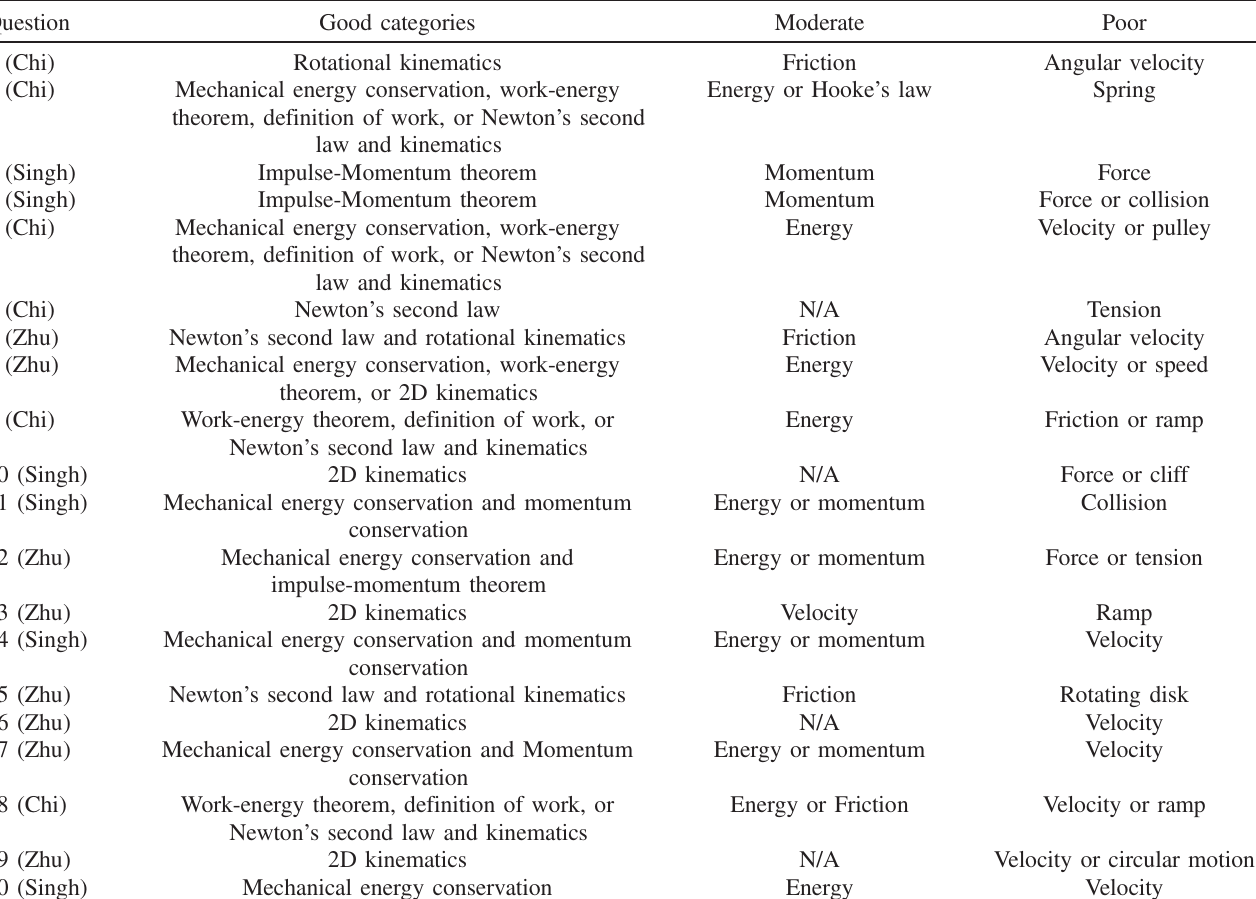
TABLE I. Examples of good, moderate, and poor categories for each question. The family name in parentheses represents the source of the question. The item N/A represents that few of the students ’ answers were evaluated as moderate for the corresponding questions.